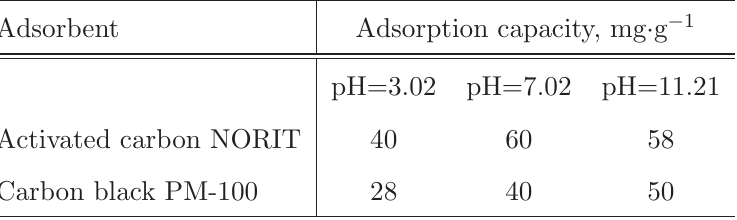
Table 1 Capacity of adsorption of the disperse carbonaceous matrices on catalase immobilization at acidic, neutral and alkaline pH of the solution for enzyme